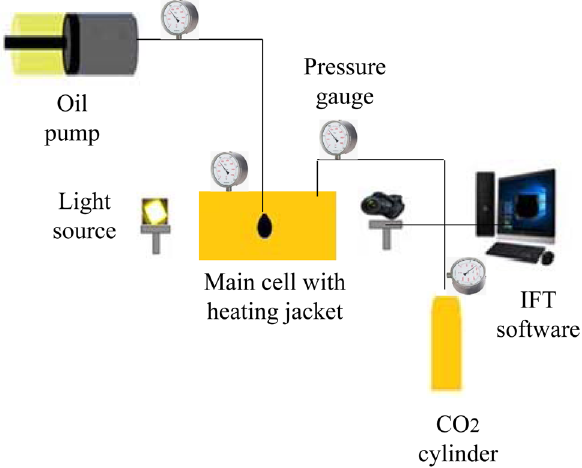
Figure 1. Schematic of high pressure and high temperature interfacial tension for CO 2 -oil